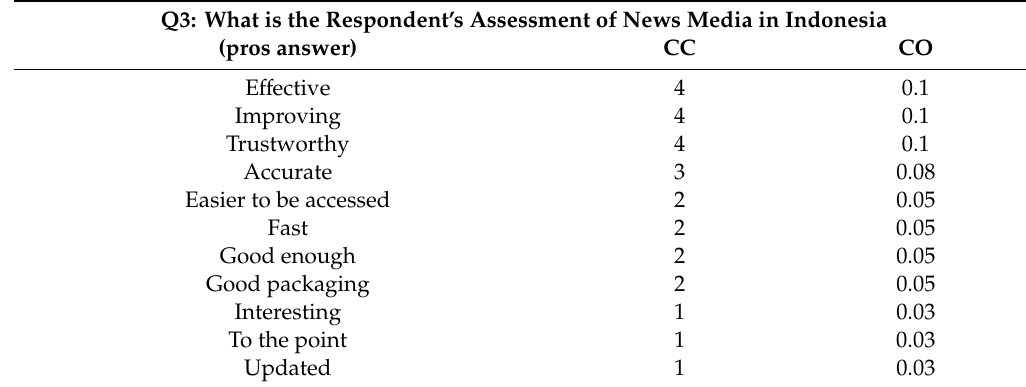
Table 18. Co-occurrences of Question 3,